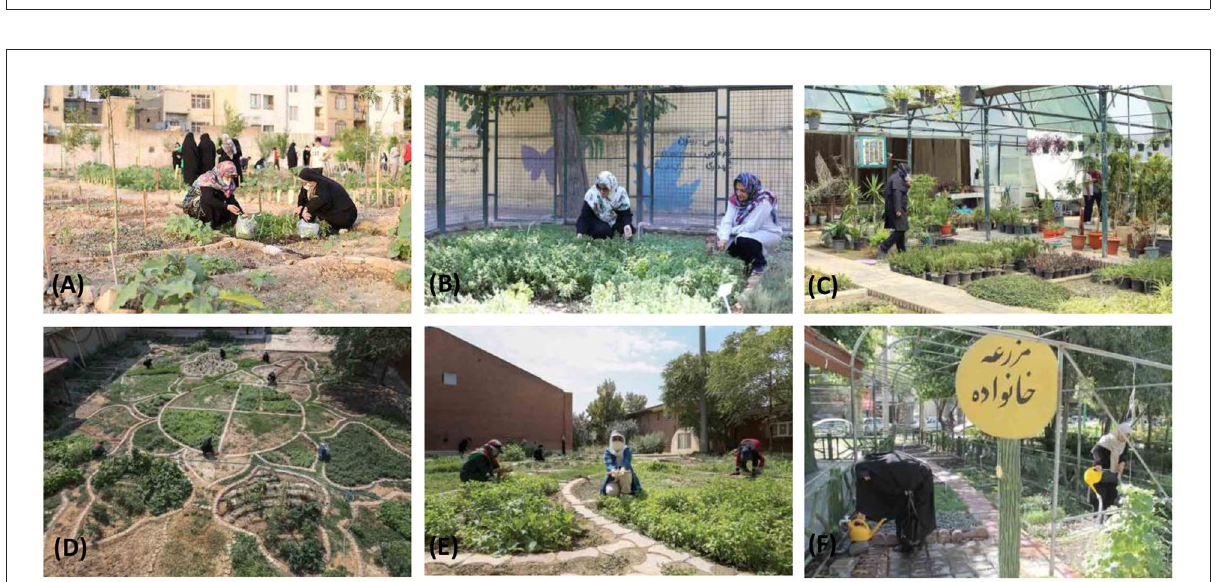
FIGURE3 Community gardens in Tehran. (A) Hashemabad garden, (B) Almahdi garden, (C) Hourfar garden, (D,E) Shariati garden, and (F) Almahdi garden.